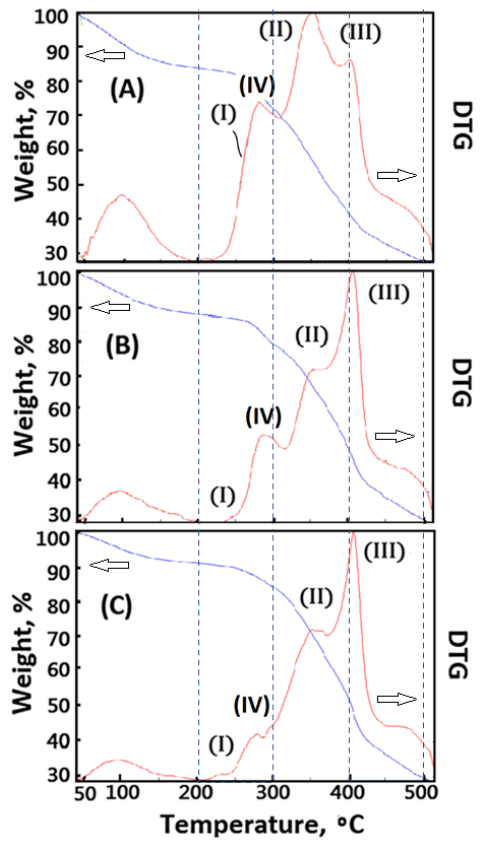
Figure 8. Thermogravimetric analysis of the composite foam materials with CaCl 2(aq) : ( A ) PCFM1H, ( B ) PCFM2H, and ( C ) PCFM3H.